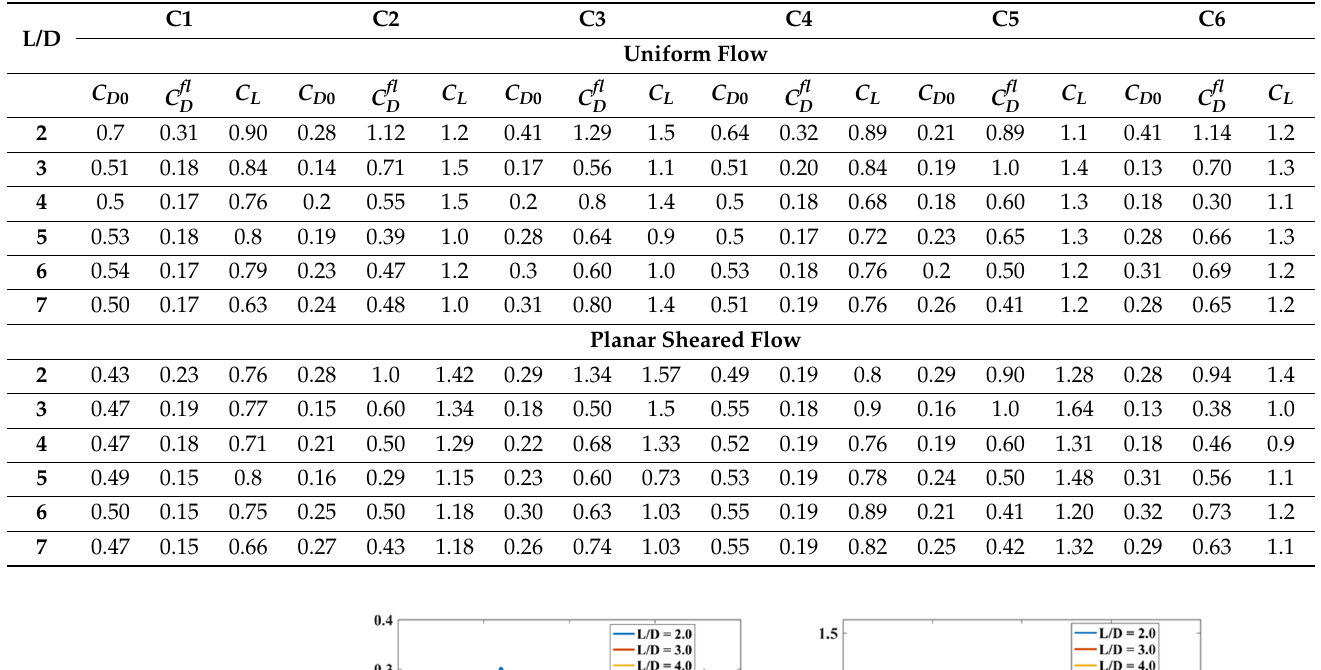
Table 2. Hydrodynamic force coefficients were obtained in the first series of simulations for the structures with the first cross-sectional shape.